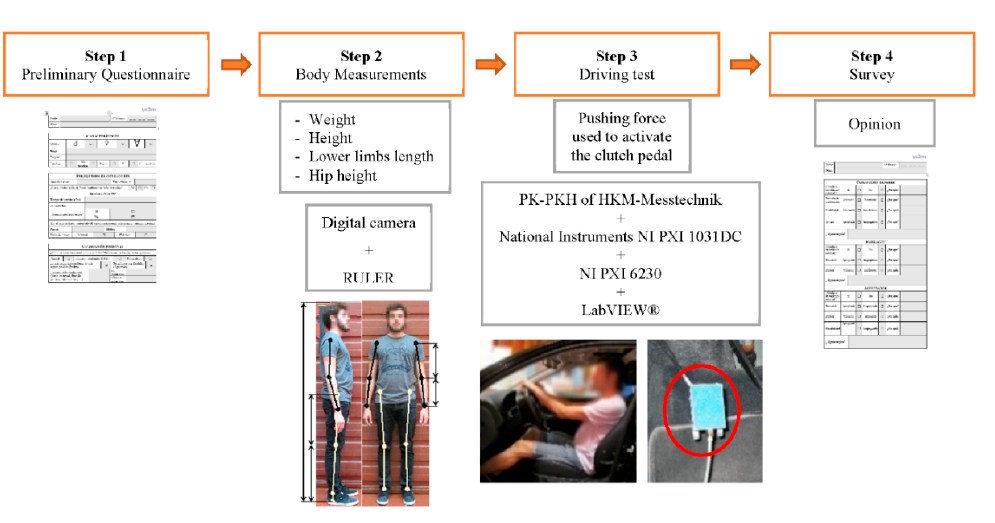
Figure 2. Steps each volunteer must complete in the first set of test. Information collected in every step is described together with the equipment used.